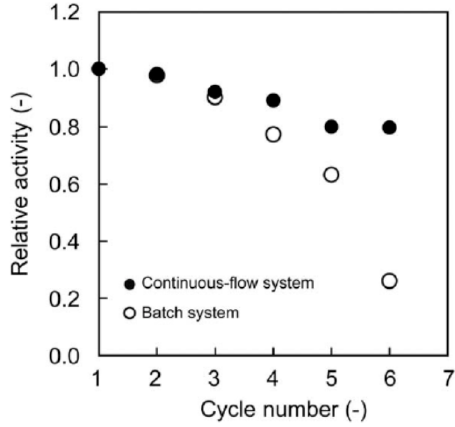
Figure 3. Storage stability of PdNPs-loaded membrane in continuous-flow ( • ) and batch (o) system for Suzuki coupling reaction. (Reprinted from Ref.17).